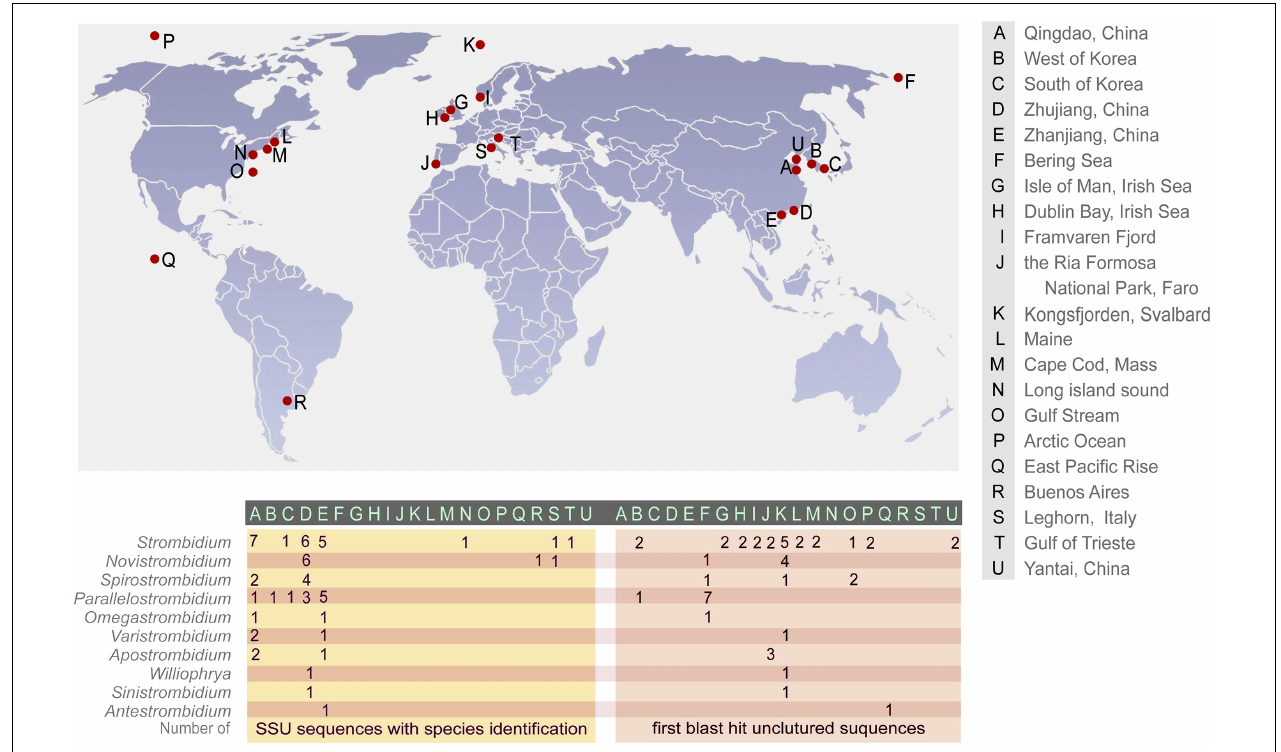
FIGURE 5 | Global geographic distribution of the 12 genera of Strombidiidae based on SSU